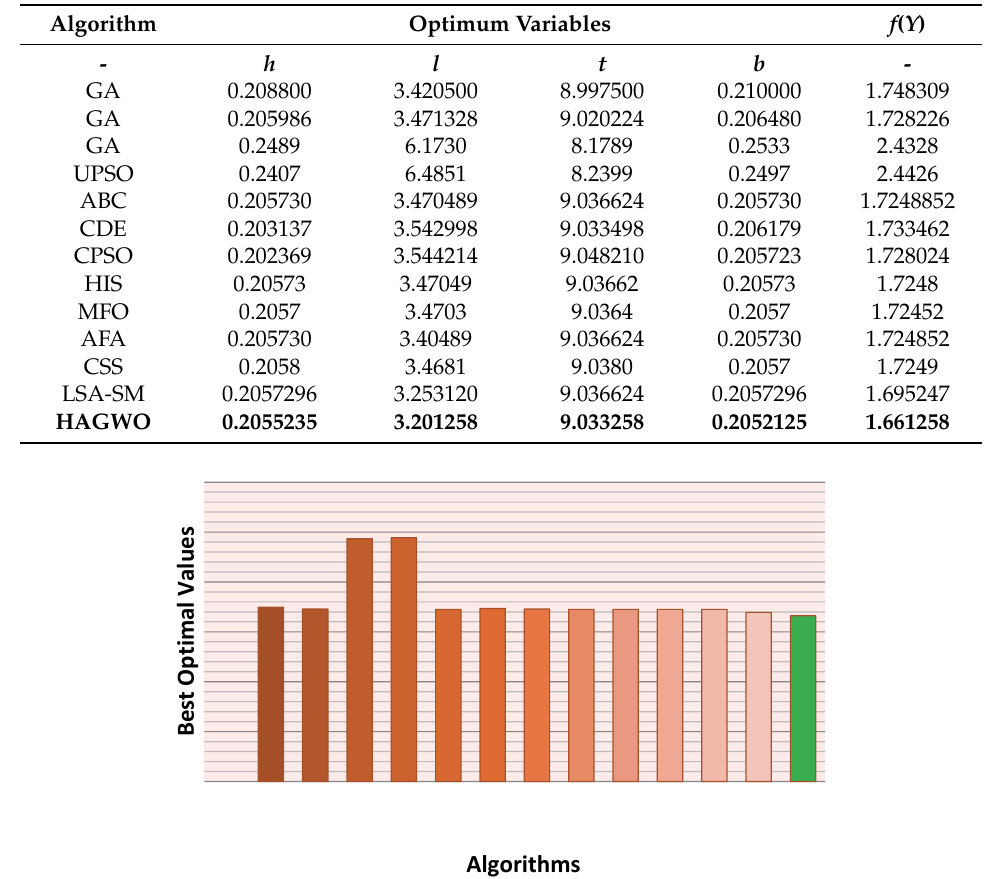
Table 11. Best optimal solutions of the welded beam design by metaheuristics.